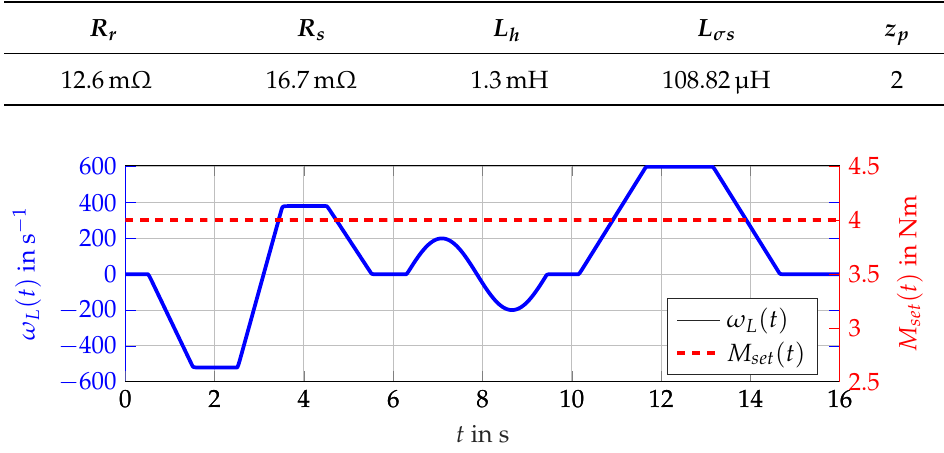
Figure 11. Used scenario for the simulation. M set ( t ) (red, dashed) and ω L ( t ) (blue, solid).